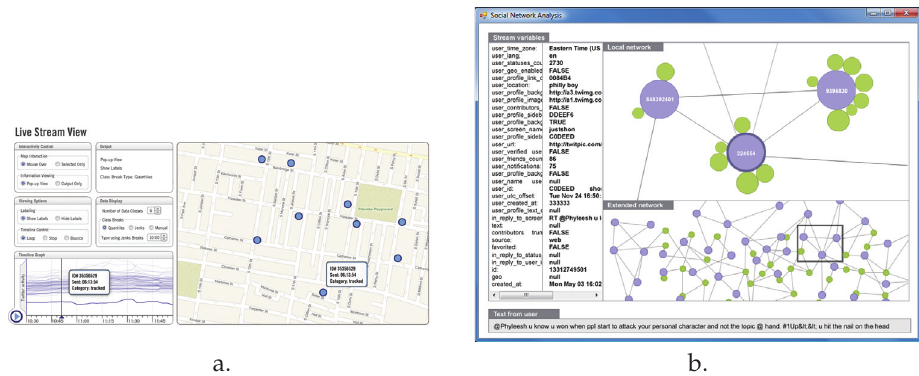
Figure 6: Individual linked map-timeline and social network analysis views in TwitterHit- ter. The left view allows analysts to retrieve a spatiotemporal record of a suspect’s activity on twitter. The right view can uncover all potential connections among suspects through network group of twitterers within a region. The views are courtesy of Jeremy D. White from Figures 3 and 4 in